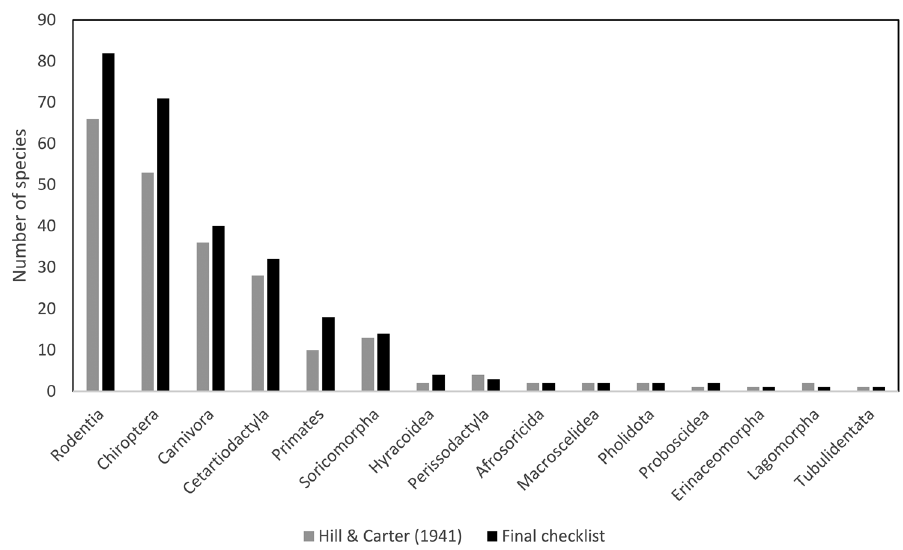
Figure 2. Histogram summarising species number of Angolan terrestrial mammals per order based on Hill and Carter (1943) and the current